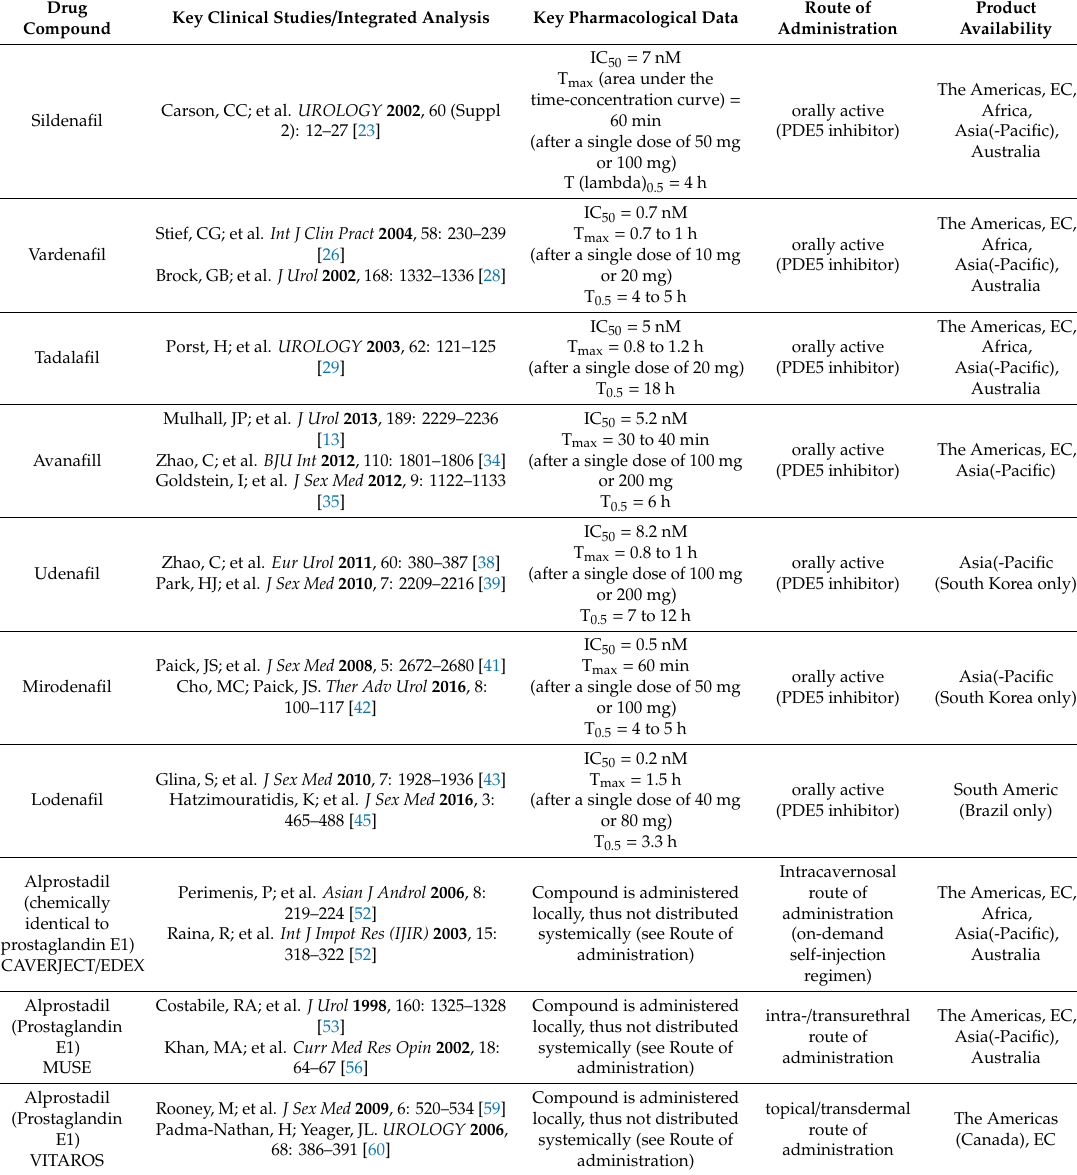
Table 1. Clinical trials (randomized, placebo-controlled and double-blinded) or integrated analyses of studies that have investigated the e ffi cacy and safety of vasoactive drugs in cohorts of patients with ED of organogenic / neurogenic origin. All studies listed meet the evidence-based medicine (EBM) level